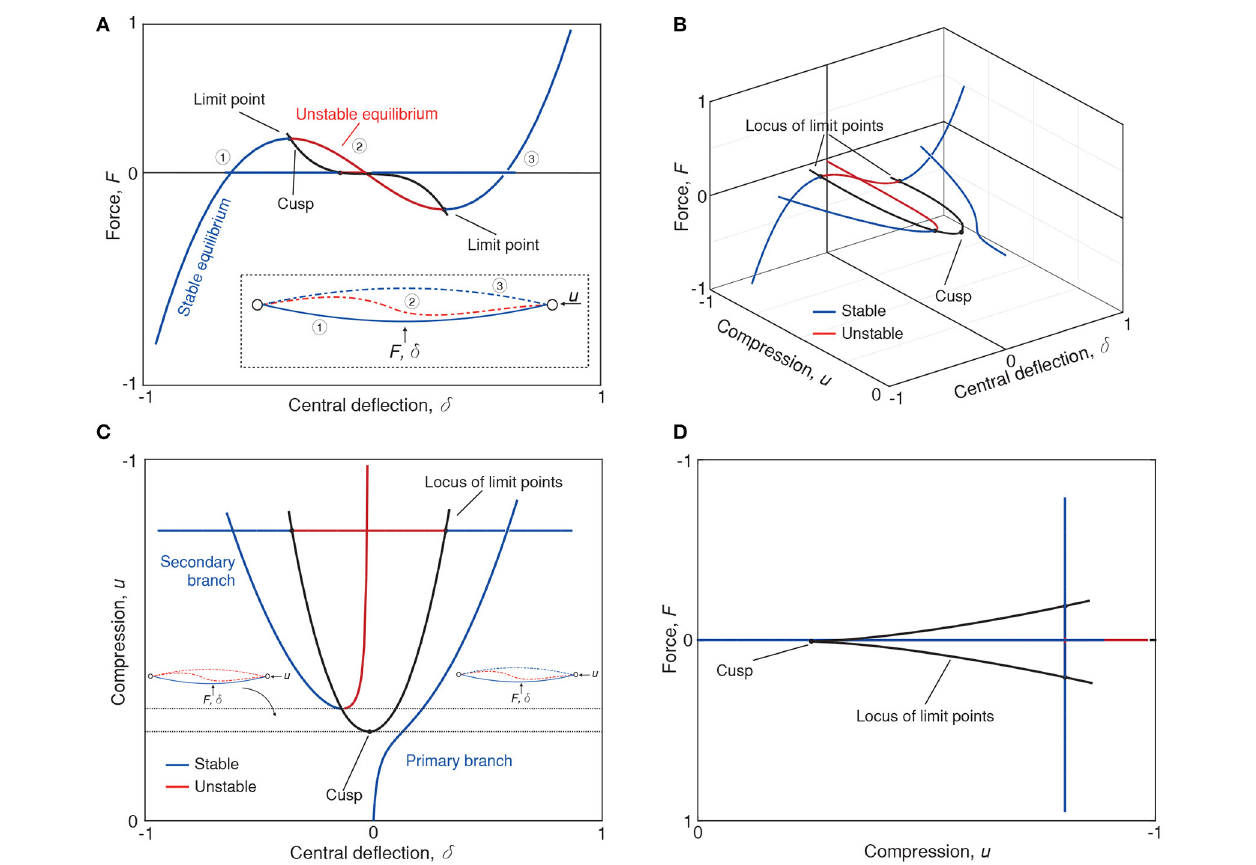
FIGURE 19 | (A) Equilibrium path of force ( F ) vs. central deflection ( δ ). (B) Compression-central deflection-force space showing a broken pitchfork and the locus of limit points of the snap-through curve. (C,D) Show the locus of limits point in central deflection-compression and compression-force space, respectively.